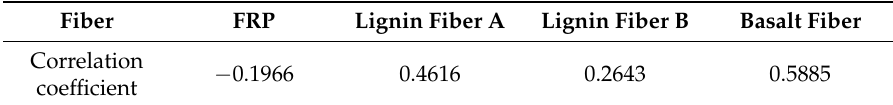
Table 9. Pearson correlation coefficient between surface energy of asphalt and increase percent of shear strength